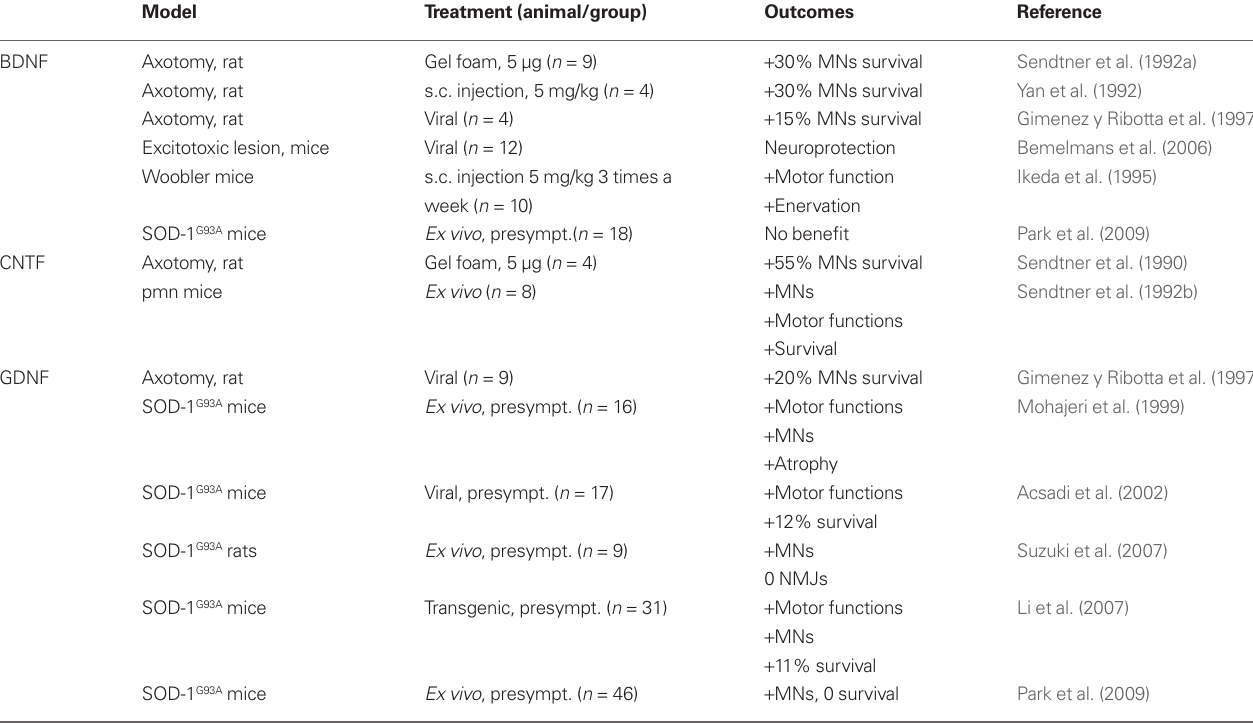
Table 1 | Listed are classic neurotrophins that have been evaluated in animal models related to ALS. Given are the respective animal model, the application mode of the factor, and the outcome of the